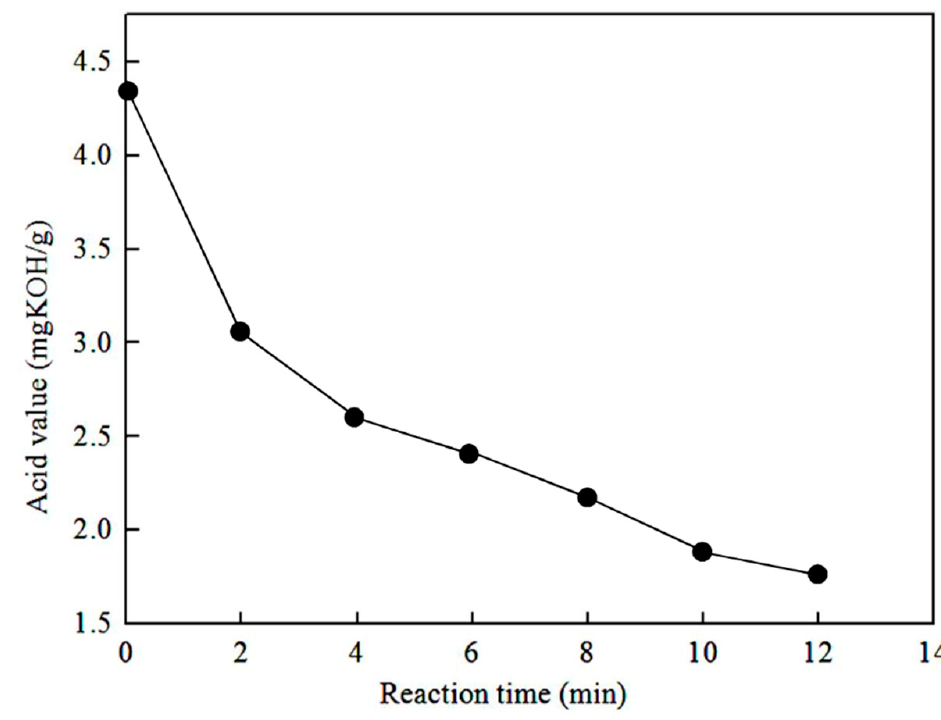
Figure 5. Effect of reaction time on the acid value.